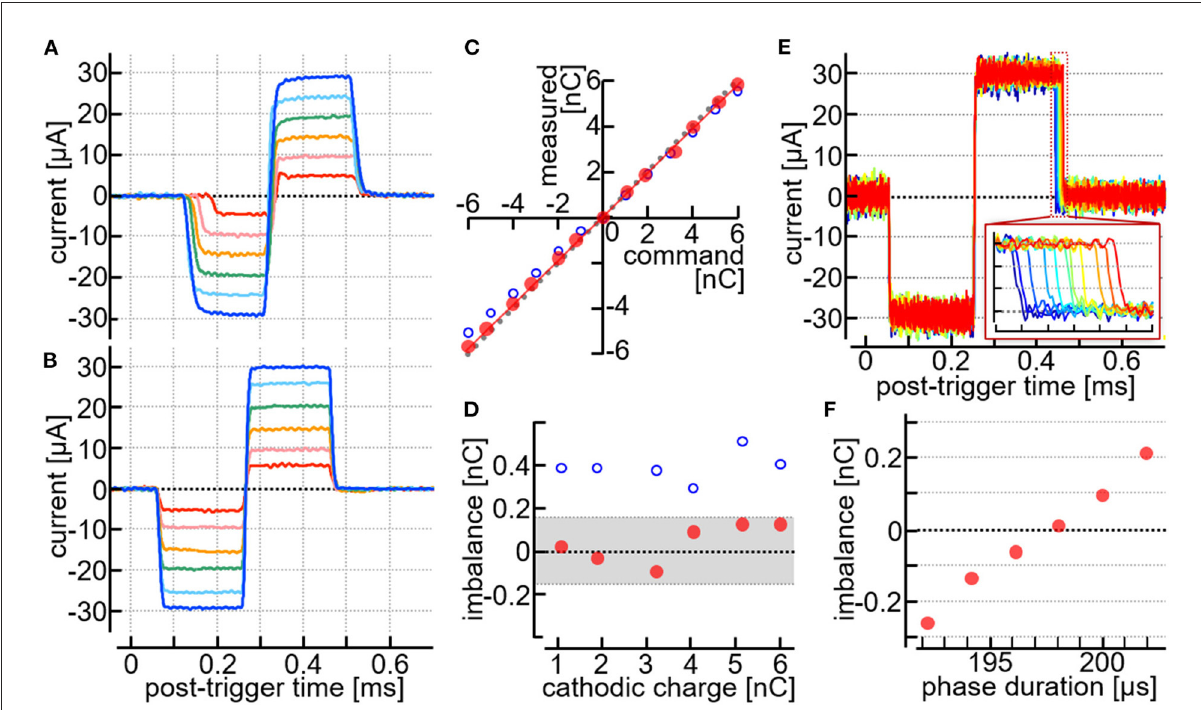
FIGURE5 Stimulus current pulses recorded in animals in vivo . (A,B) Recorded traces of the current pulses generated by a desktop stimulator (A) and the stimulation module (B) with the same MEA in the same rat. (C,D) Measured current amplitudes plotted against the command amplitudes (C) , and the imbalance charges plotted against the charges delivered by the cathodic pulses (D) . Data taken from the results in (A,B) . (E,F) Testing the pulse width adjustments of the anodic phase. The animal was different from one used in (A–D) . (E) Current traces with different settings of the anodic pulse width. Inset in (E) , Expanded view of the offset of the anodic phase. (F) Imbalanced charges plotted against the command duration of the anodic phase. The imbalanced charges were calculated as the time integral of the recorded current trace from time zero to